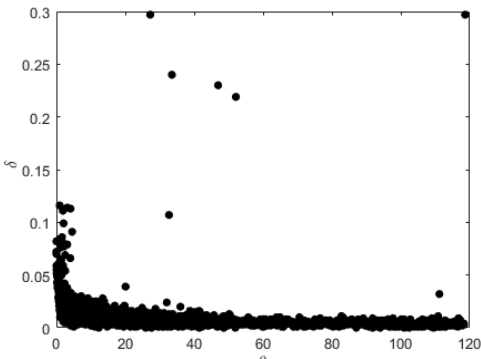
Figure 2. In the decision graph, each point in the graph represents every point in the data set. It is not difficult to see from the graph that points with larger 𝜌 (cid:3036) and 𝛿 (cid:3036) are more suitable to be cluster center points, and points with smaller 𝜌 (cid:3036) value and larger 𝛿 (cid:3036) value are classified as outliers.